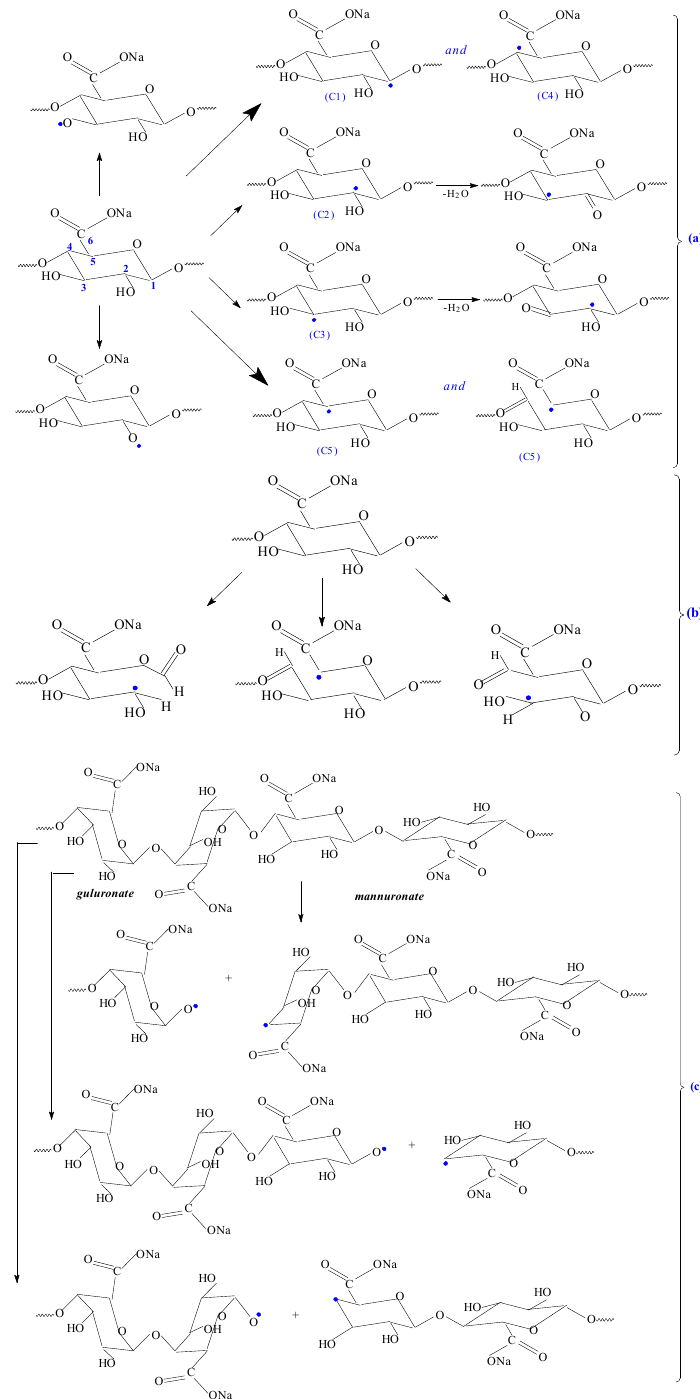
Figure 7. Possible mechanism for obtaining radicals by irradiation from sodium alginate.